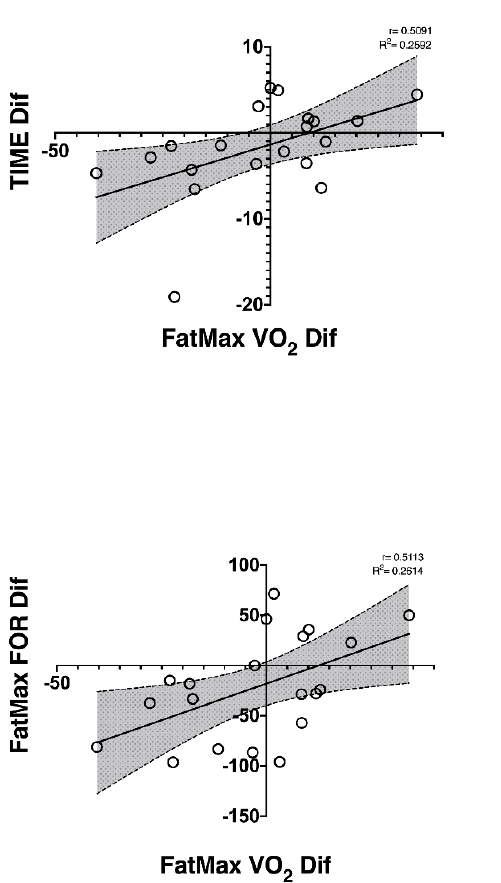
Figure 1. Correlations found between metabolic and performance variables in the FatMax after an incremental test at the end of the off-season period in well-trained cyclists. All correlations were significant <0.05.